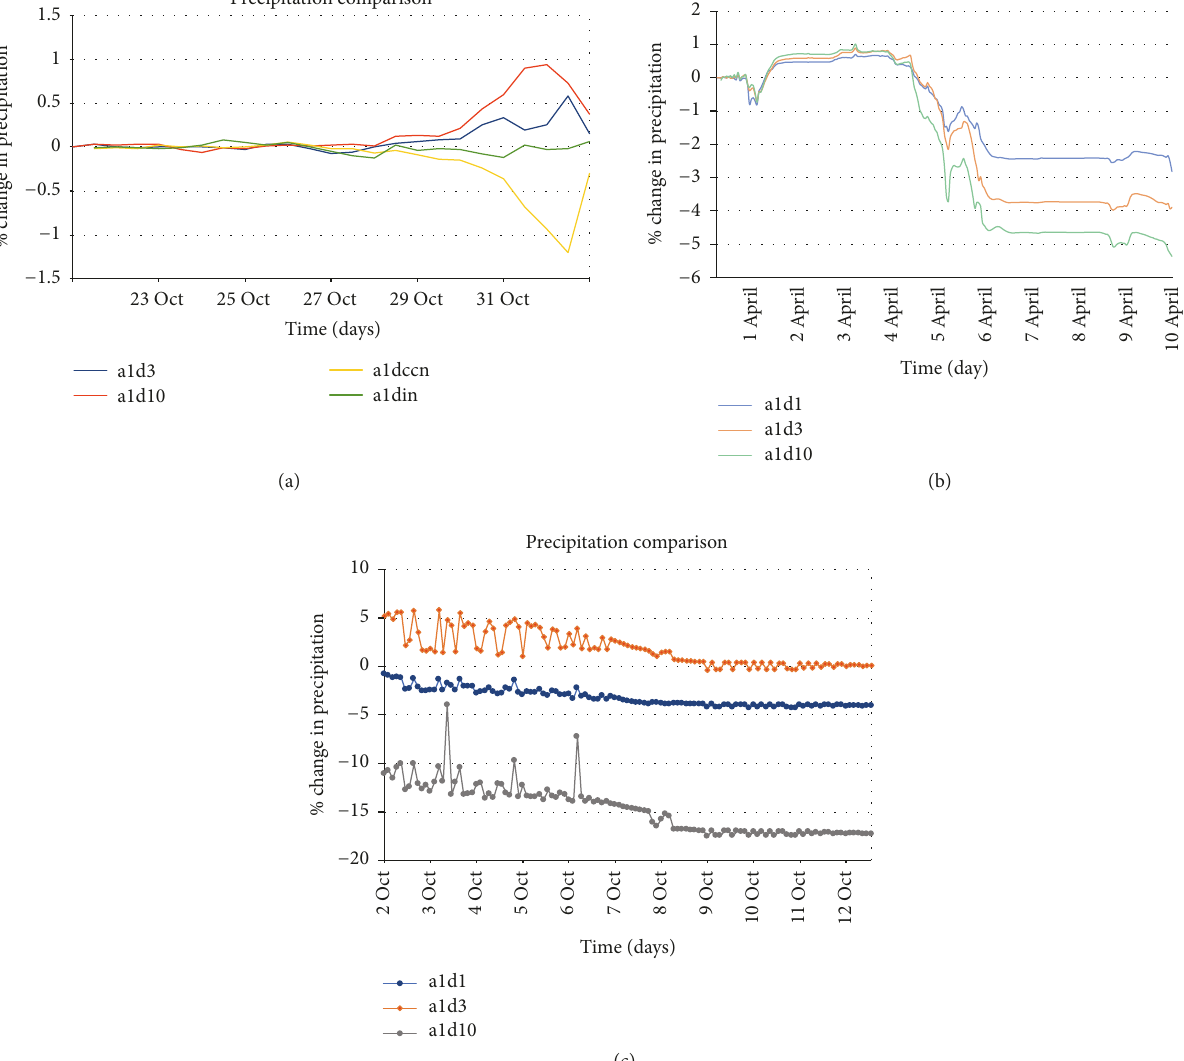
Figure 4: Plot of precipitation with no dust compared to a1d3, a1d10, a1dccn, a1din for Case Study 1; blue: a1d3, red: a1d10, green: a1din; yellow: a1din (a). Plot of precipitation with no dust compared to a1d1, a1d3, a1d10; blue: a1d1, red: a1d3, green: a1d10 for Case Study 2 (b). Plot of precipitation with no dust compared to a1d1, a1d3, a1d10; blue: a1d1, red: a1d3, gray: a1d10 for Case Study 3 (c).